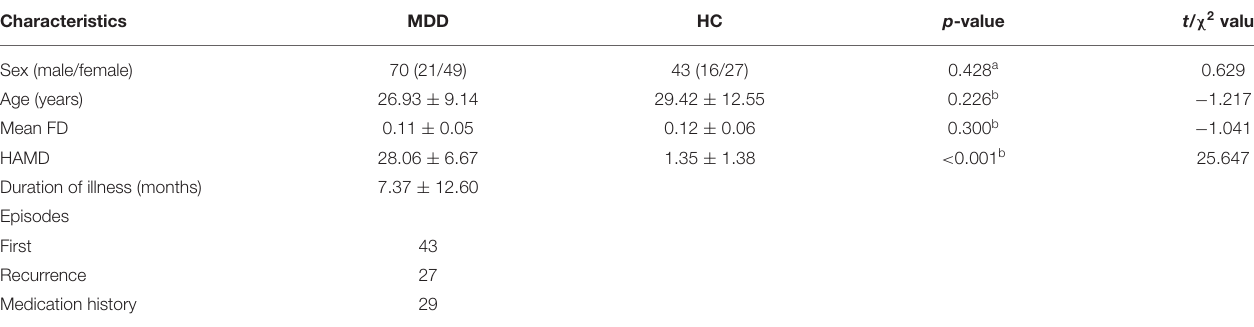
TABLE 2 | Demographic and clinical